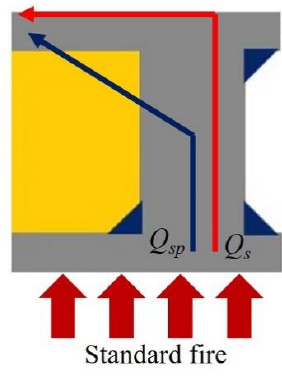
Figure 12. Heat flow path at the parameter bar.